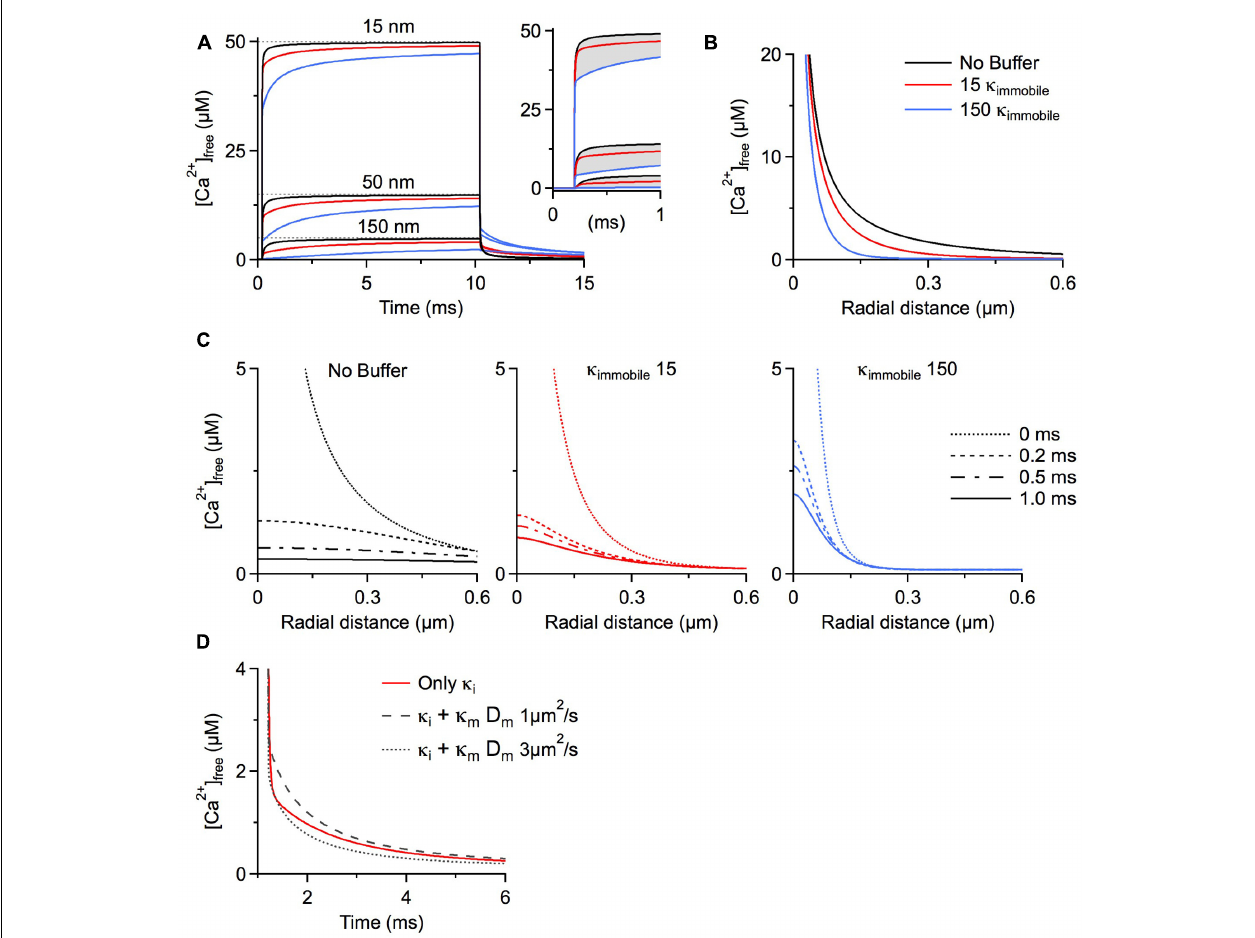
FIGURE 1 | Simulations were run using CalC (Matveev etal., 2004; http://web.njit.edu/ ∼ matveev;Version 6.7.4). Resting calcium concentration was set at 100 nM.We simulate a calcium current of 0.2 pA through a generic calcium channel. Parameters for the immobile buffer